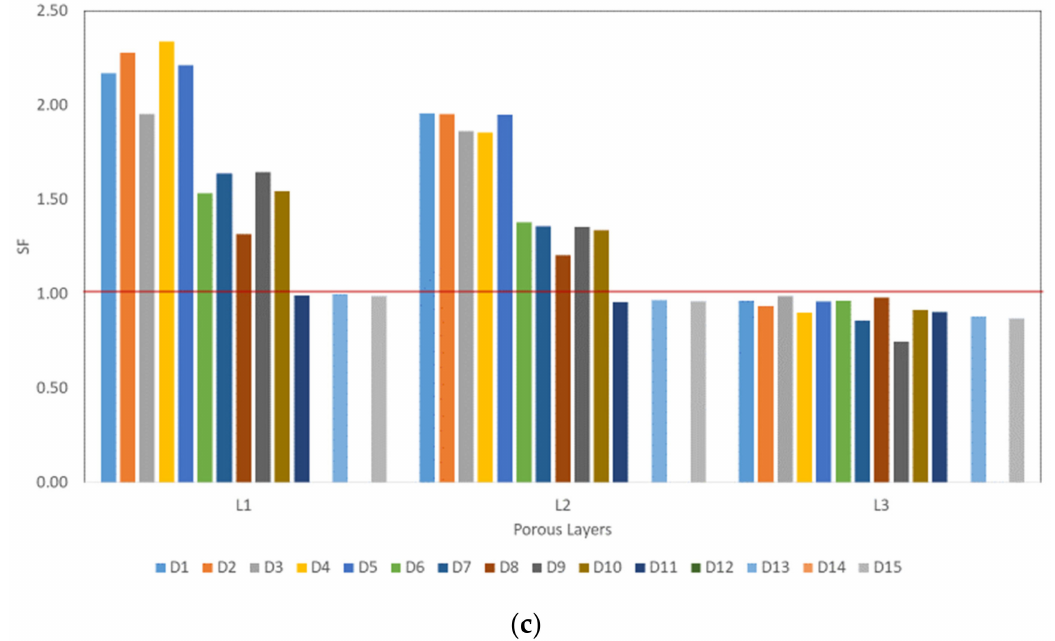
Figure 8. Stress ratio between the relevant stem layer yield strength ( Y sl ) and the maximum stress value of that layer ( σ Lm ) ; ( a ) at 1 km/h walking speed, ( b ) at 3 km/h walking speed, and ( c ) at 5 km/h walking